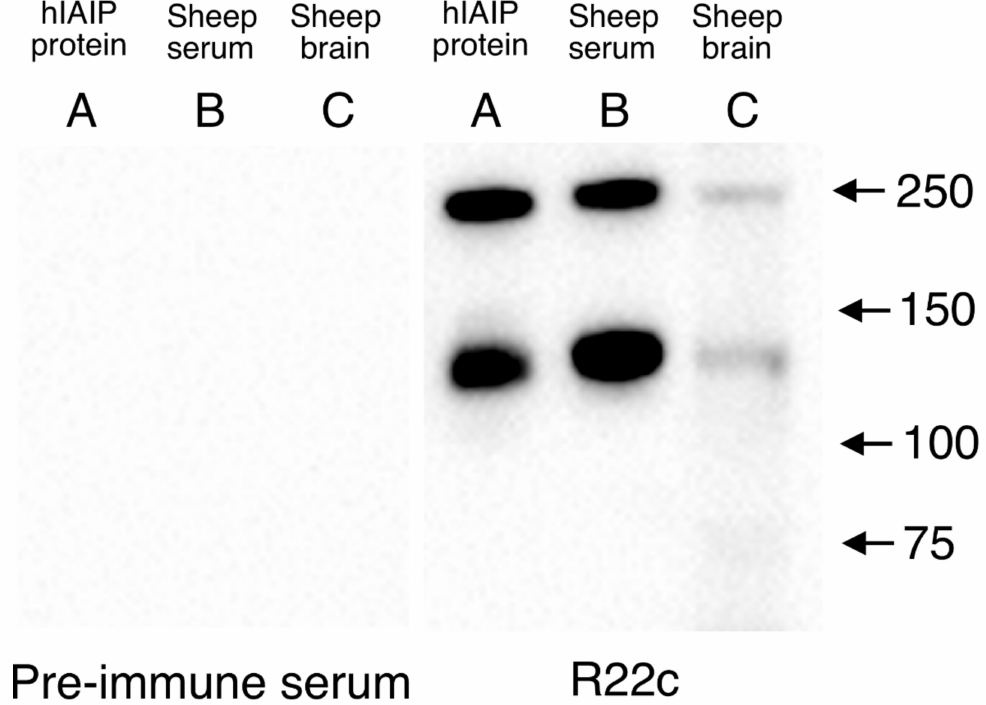
Figure 1. Immunohistochemical expression and quantification of IAIPs in the cerebral cortex and Western immunoblot to verify R-22c pAb specificity. Purified human IAIP protein was loaded on lane A. Sheep serum was loaded on lane B. Tissue extraction from the sheep brain was loaded on lane C. The pre-immune serum used as a negative control for the R-22C pAb did not recognize IAIP bands, whereas the R-22c pAb detected two bands, at approximately 250 and 125 kDa in the human IAIP protein, sheep serum, and sheep brain extraction (lane A, B and